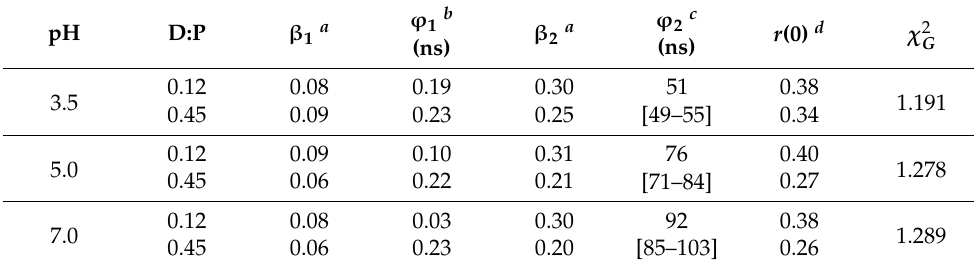
d The time-zero or initial anisotropy is the sum of the two amplitudes of the decay, 2 . r (0) = β 1 + β 2